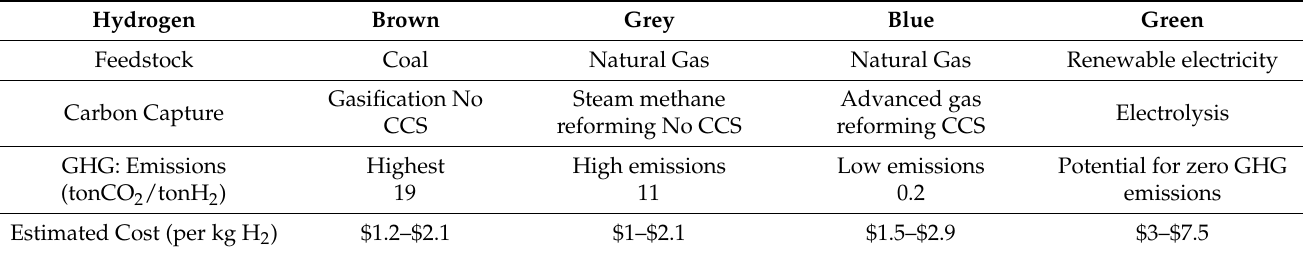
Table 1. A comparative summary of hydrogen production processes and hydrogen color codes.